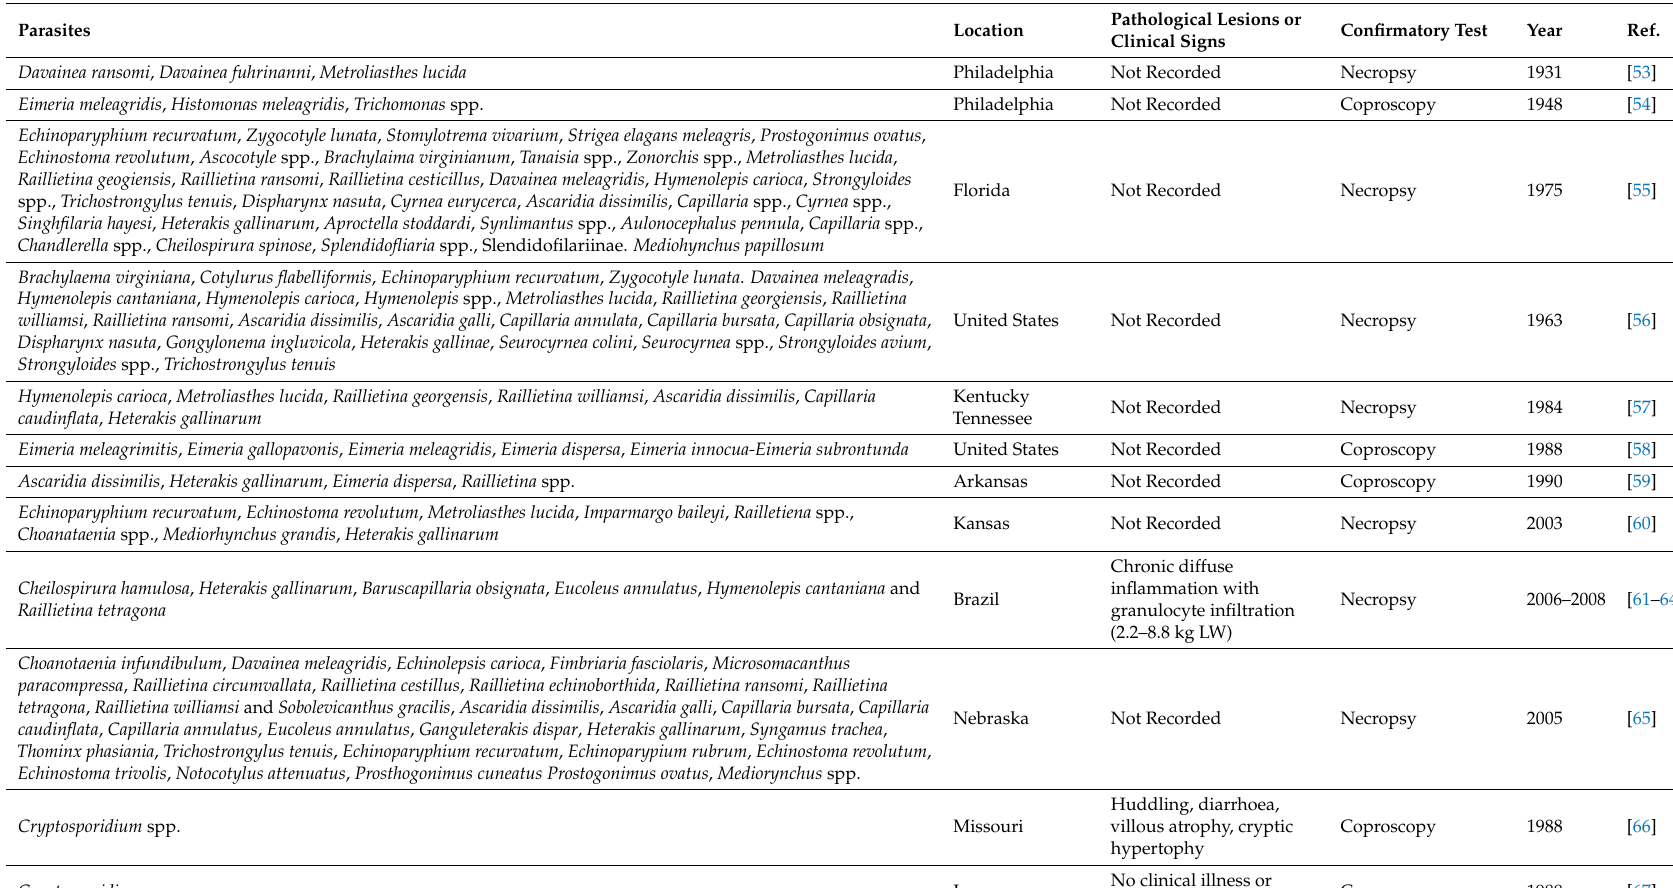
Table 5. Gastrointestinal Parasites present in Turkeys and its effect on the